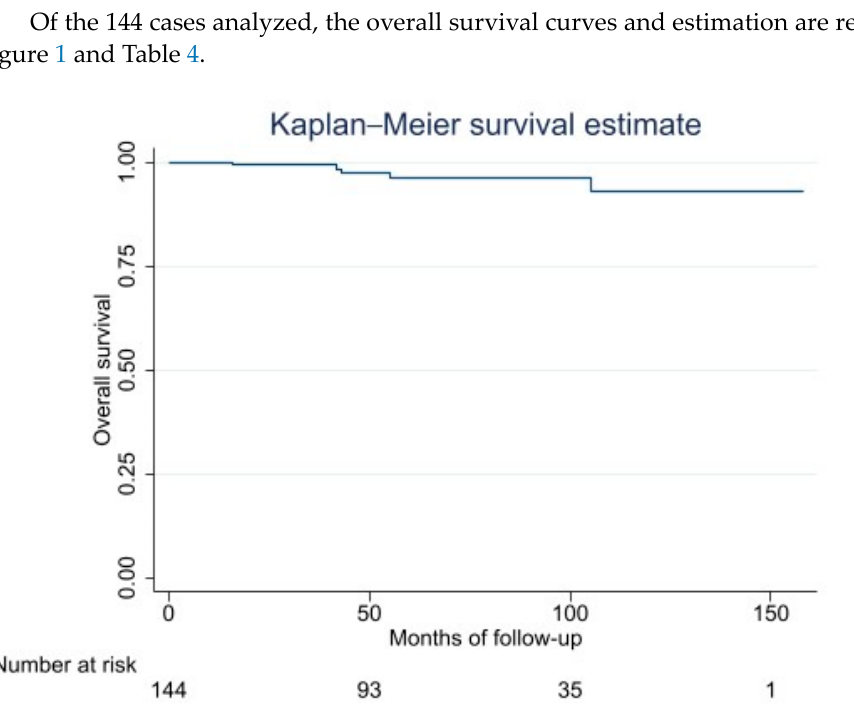
Figure 1. Kaplan–Meier Overall Survival Curve. Table 4. Overall Survival: Kaplan–Meier Survival Estimation.